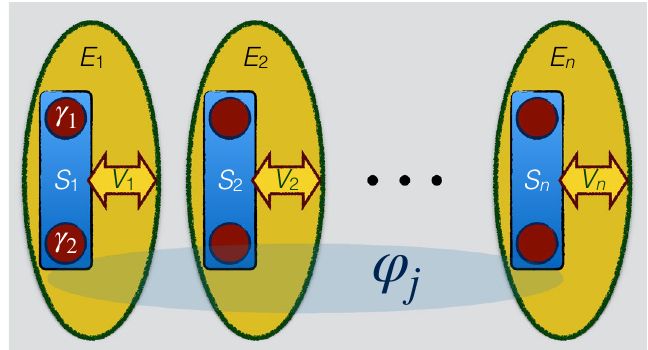
1, 2, . . . , n ), each one built by Figure 6. Illustration of a system of n noninteracting topological qubits S i ( i = two Majorana modes γ 2 i 1 and γ 2 i (only γ 1 , γ 2 are explicitly indicated for simplicity), locally interacting by V i to − the environment E i (constituted by electrons and holes). The n qubits are initially prepared in a state containing relative phase parameters ϕ j between the computational basis states. This figure was created using Keynote, version 10.3.9 (7029.9.8), URL: https:// apps. apple. com/ it/ app/ keyno te/ id409 183694? mt=